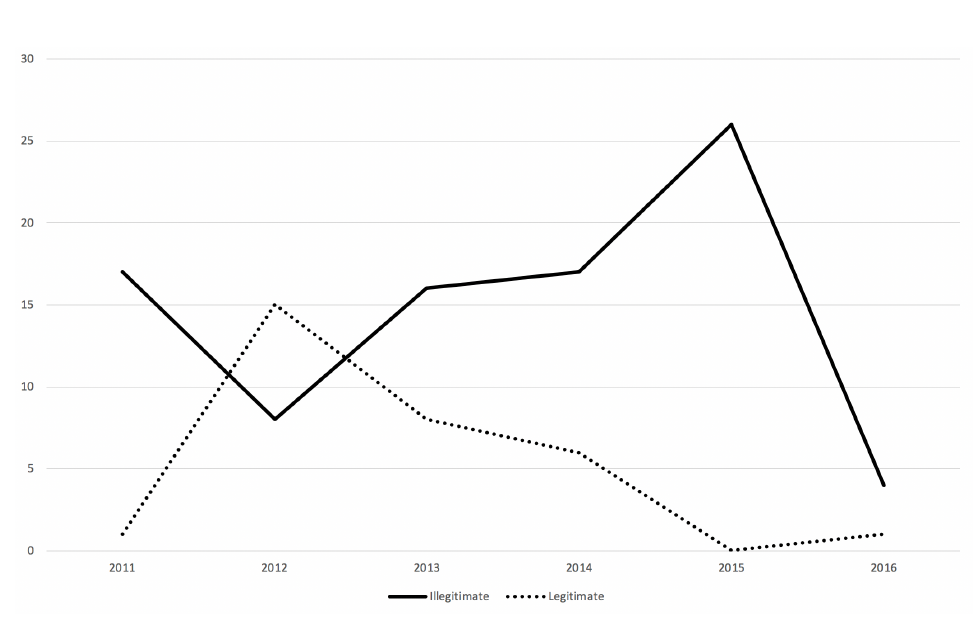
Figure 1: U.S. references to the legitimacy and illegitimacy of